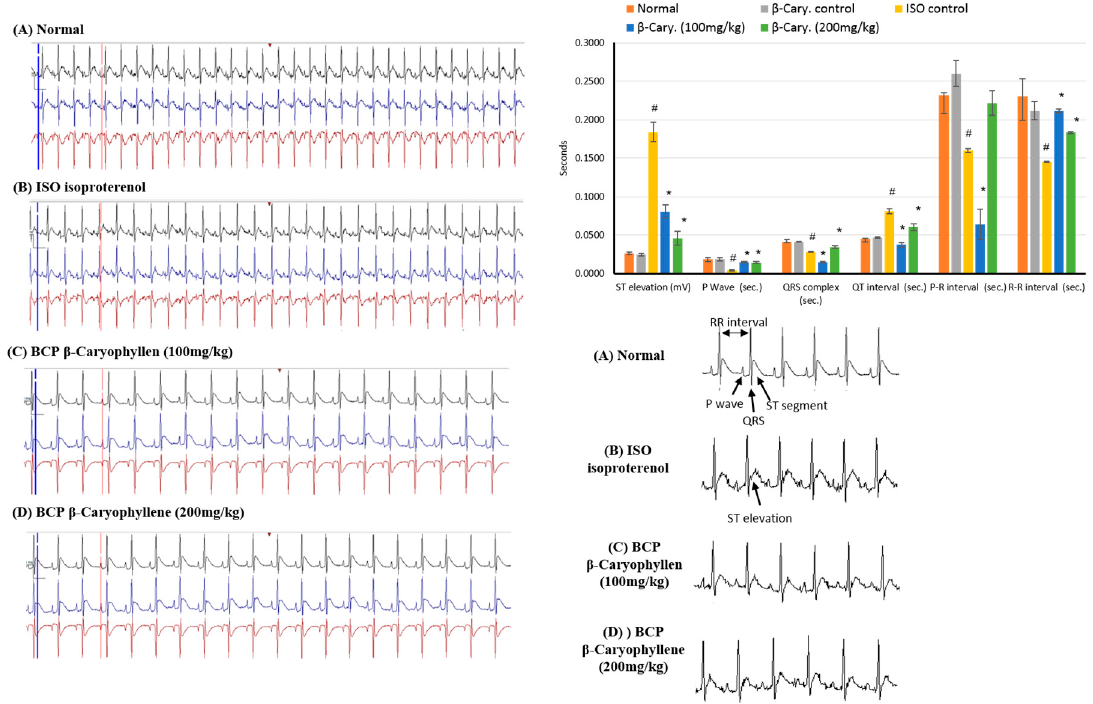
Figure 3. Representative traces of the electrocardiographic (ECG) showing the e ff ects of β -caryophyllene treatment (100, 200 mg / kg) for 21 days on ECG components in ISO-induced myocardial infarction. All values were expressed as mean ± SD ( n = 6). ISO: isoproterenol and BCP: β -Caryophyllene. # indicates statistically significant from normal group, * indicates statistically significant from isoproterenol group, @ indicates statistically significant from β -caryophyllene (100 mg / kg) group ( p < 0.05) using one way ANOVA followed by Tukey’s test as a post-hoc analysis.